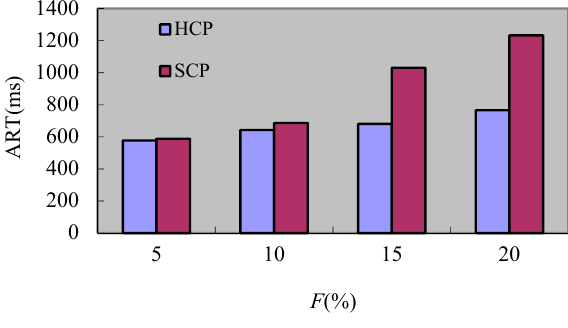
Figure 12. Impact of F on ART.